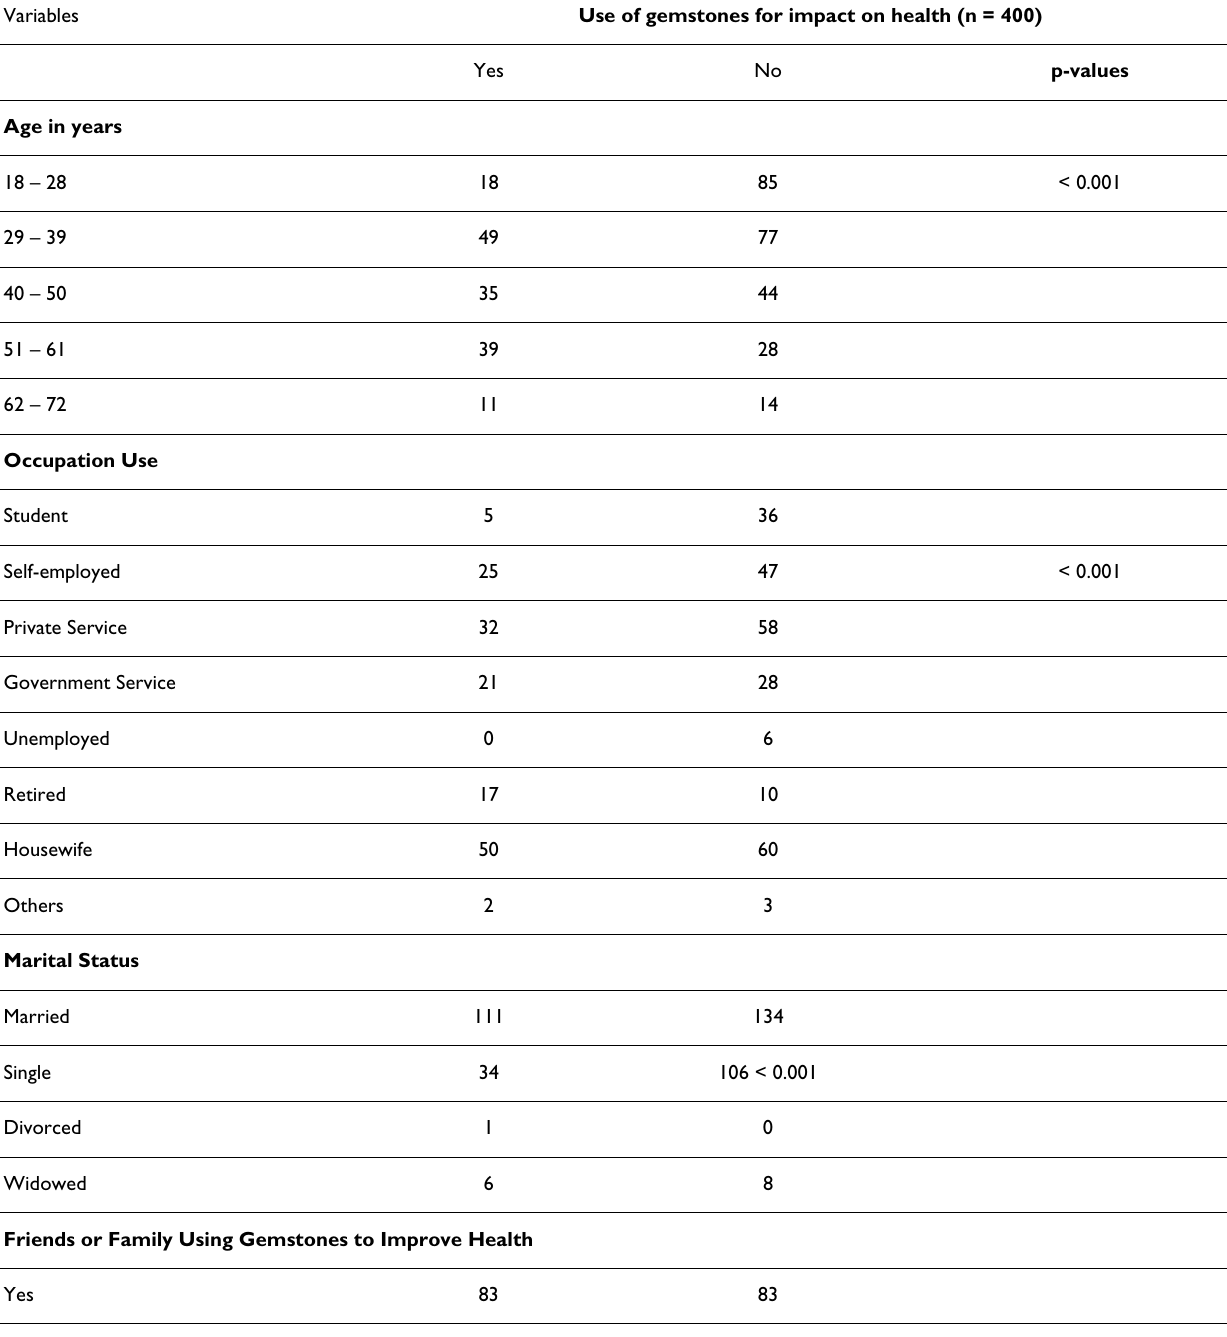
Table 7: Association of use of gemstones with effects on health Variables Use of gemstones for impact on health (n =